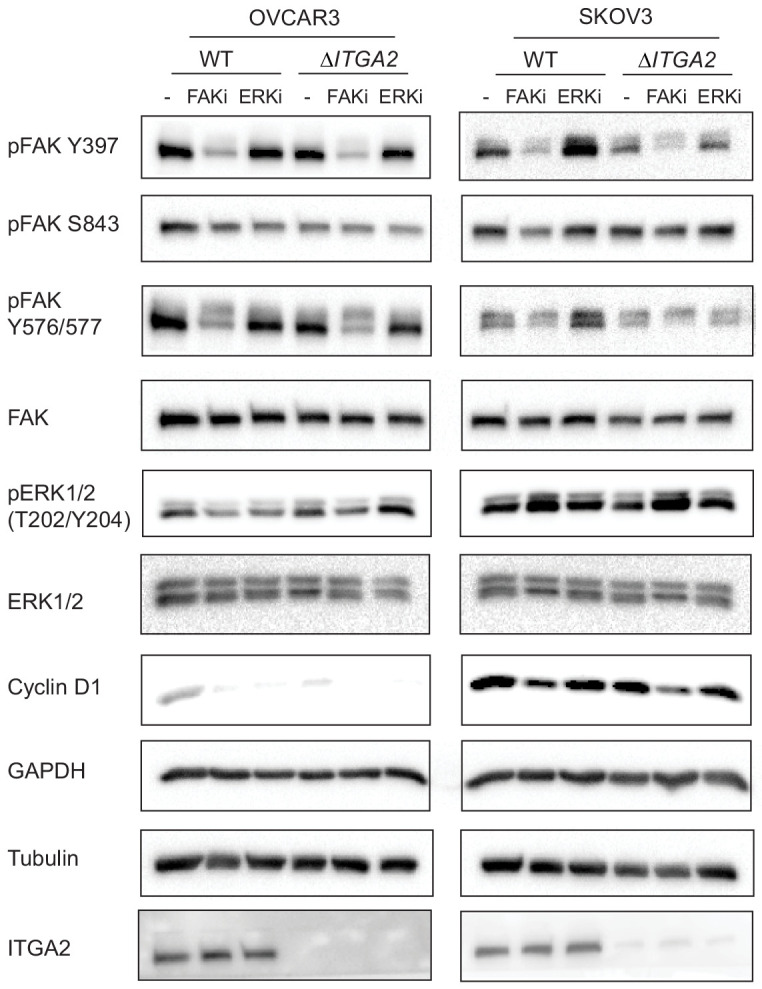
Functional inhibition targeting ITGA2-dependent FAK/MAPK signaling axis.Immunoblot analysis shows downregulation of FAK and MAPK(ERK1/2) phosphorylation in WT and ΔITGA2 cells after 6 hr treatment with 10 μM Defactinib (FAKi) or FR180204 (ERKi).